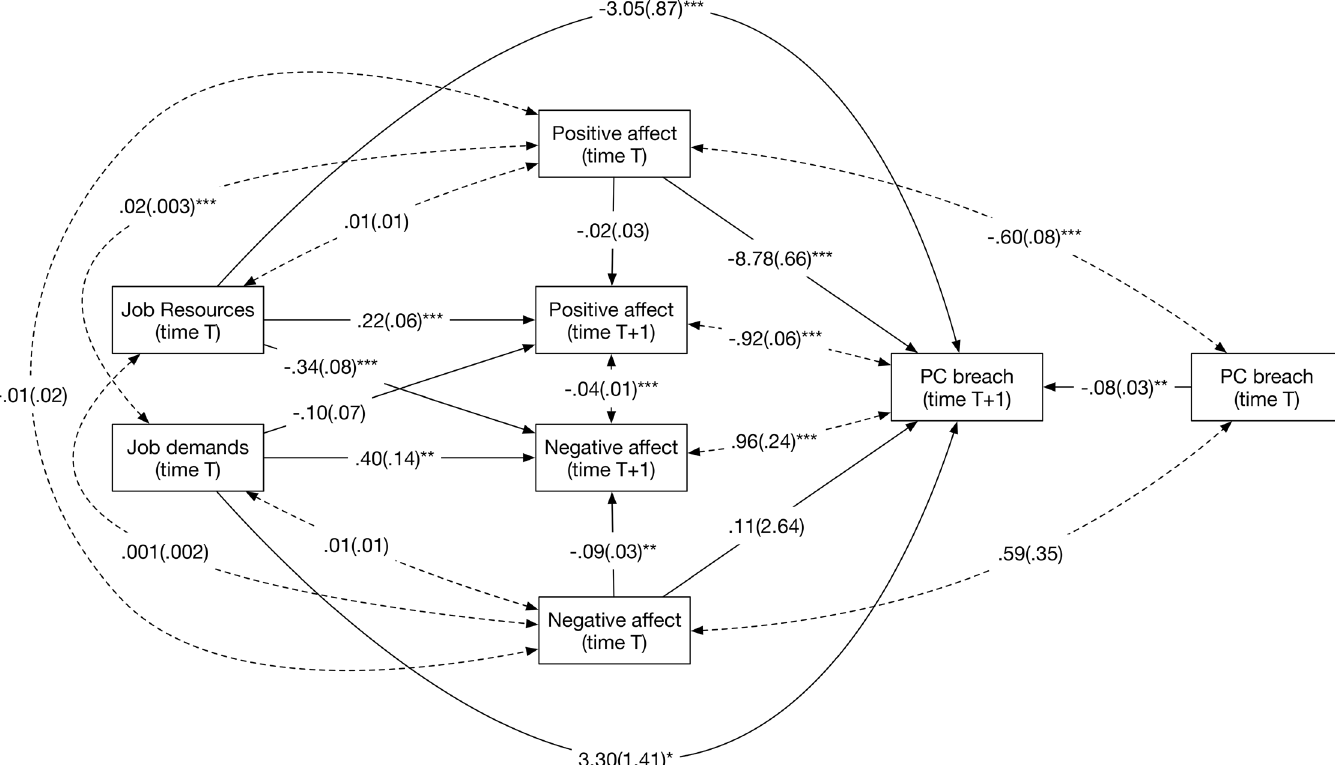
Fig 3. Path estimates from model with time-lagged relationships in Study 2. * : p < .05, ** : p < .01, *** : p < .001. Standard errors between parentheses.